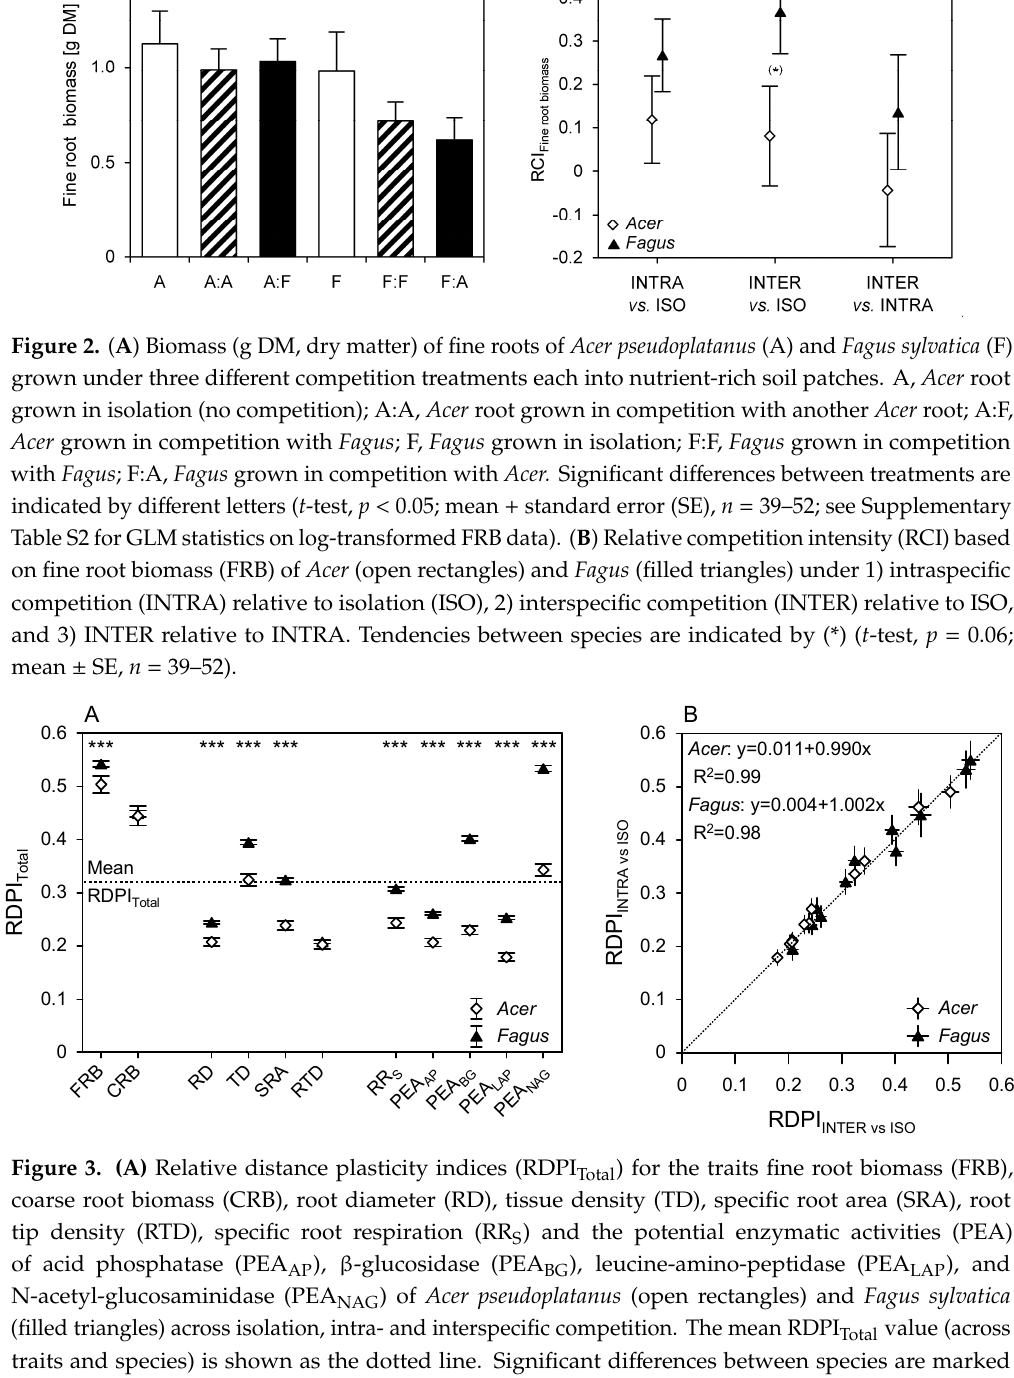
Figure 3. (A) Relative distance plasticity indices (RDPI Total ) for the traits fine root biomass (FRB), coarse root biomass (CRB), root diameter (RD), tissue density (TD), specific root area (SRA), root tip density (RTD), specific root respiration (RR S ) and the potential enzymatic activities (PEA) of acid phosphatase (PEA AP ), β -glucosidase (PEA BG ), leucine-amino-peptidase (PEA LAP ), and N-acetyl-glucosaminidase (PEA NAG ) of Acer pseudoplatanus (open rectangles) and Fagus sylvatica (filled triangles) across isolation, intra- and interspecific competition. The mean RDPI Total value (across traits and species) is shown as the dotted line. Significant differences between species are marked ( t -test, p < 0.001 ***; mean ± three standard errors (3SE)). (B) Relative distance plasticity indices under intraspecific competition (RDPI INTRA vs ISO ) vs. RDPI under interspecific competition (RDPI INTER vs ISO ; mean ± 3SE); linear regressions (formulae and R 2 ) of trait means are given for Acer and Fagus ; the 1:1 line is drawn for comparison (dotted line).